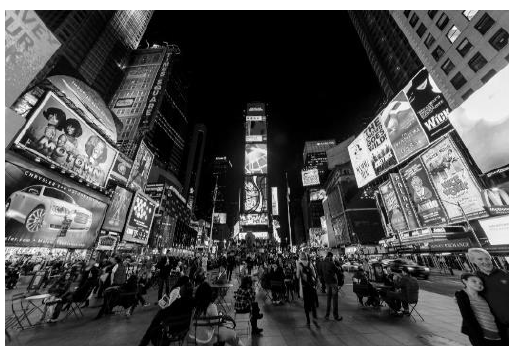
Figure 9. Quartz shopping by Gruen.